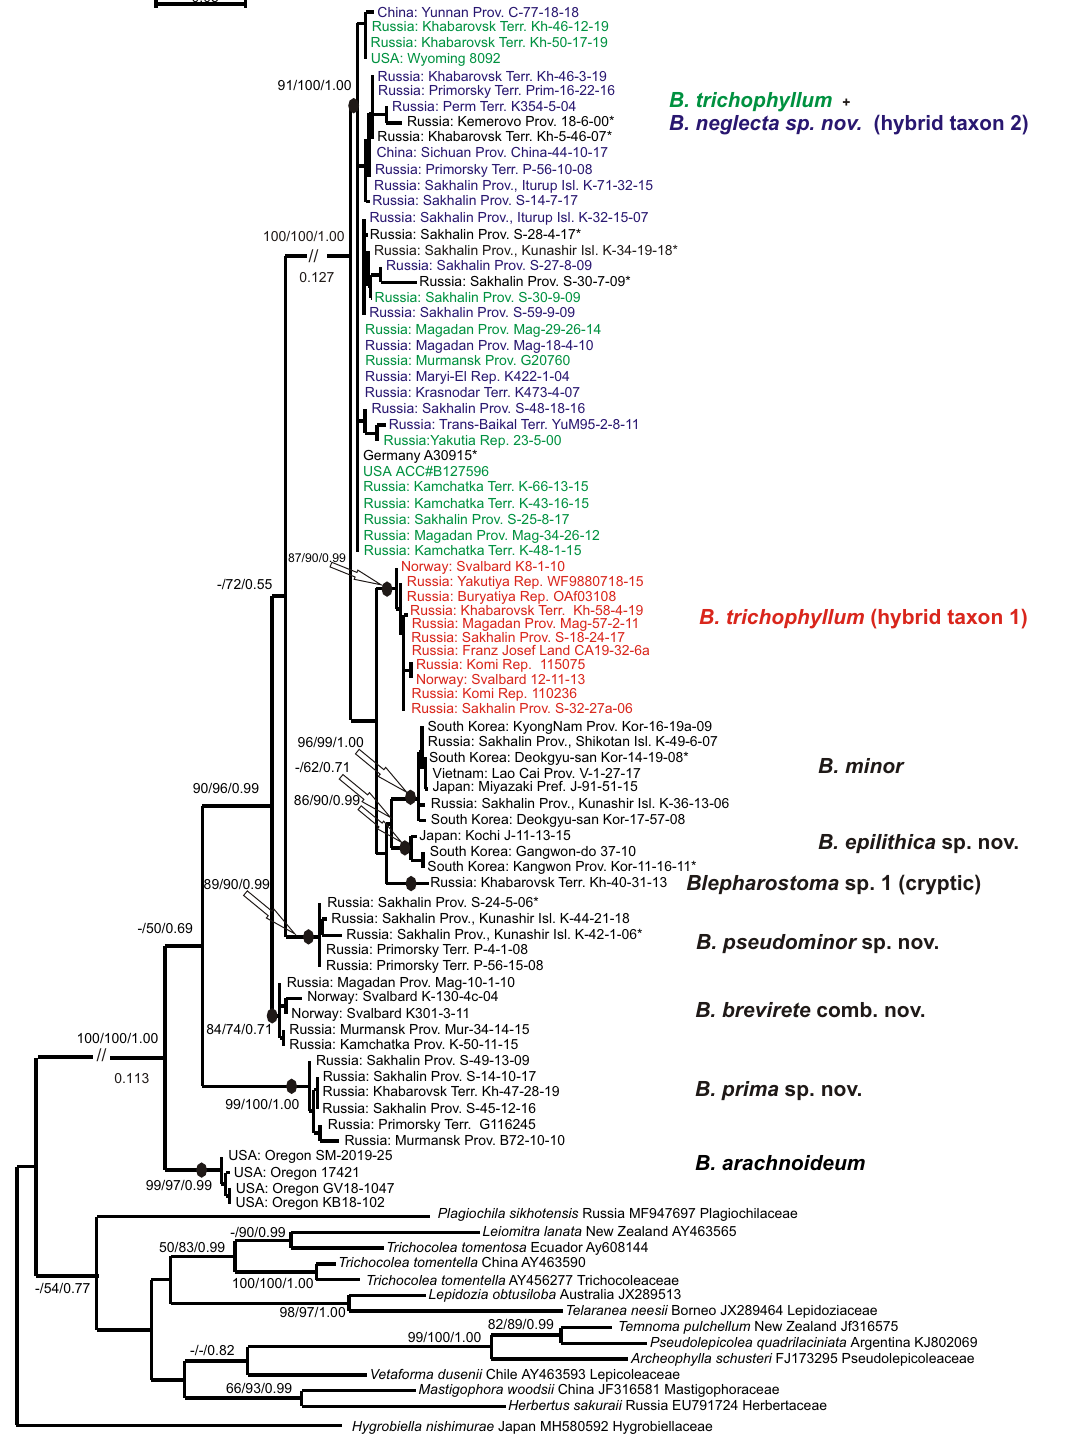
Figure 2. Phylogram obtained under the maximum likelihood criterion for the genus Blepharostoma based on the trn L-F cpDNA. Bootstrap support values are indicated under maximum parsimony, maximum likelihood, and Bayesian posterior probabilities of > 50% (0.50). The lengths of the cut branches are